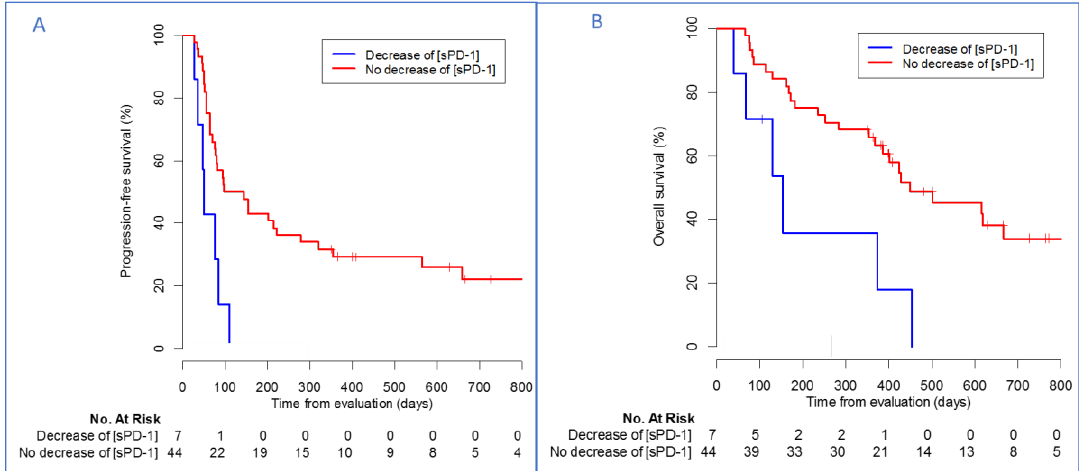
Figure 3. Kaplan–Meier estimates of patients’ ( A ) progression-free survival and ( B ) overall survival according to sPD-1 evolution between baseline and day 28. Tick marks indicate censoring of data.